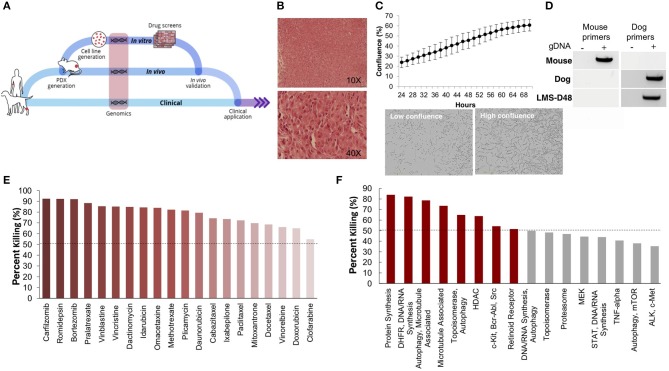
Patient-derived models of cancer enable seamless integration of high throughput drug screening with in vivo validations. (A) Schematic of the personalized medicine pipeline integrating in vitro and in vivo drug discovery and validation. (B) Hematoxylin and eosin stain of the patient derived xenograft model of the canine patient (LMS-D48) showing highly proliferative spindle-like cells. (C) The patient-derived cell line also displays a high proliferation rate, with an estimated doubling time of 26–36 h, and spindle-like mesenchymal morphology. (D) A species-specific PCR using mouse- and canine-specific primers confirms that the patient-derived cell line is of canine origin. (E) A preliminary drug screen of 119 FDA-approved compounds in the LMS-D48 cell line identified single standard-of-care agents and novel drug candidates. (F) Analysis of drug screen data at the pathway level showed sensitivity to protein synthesis, DNA/RNA synthesis, autophagy, and HDAC inhibitors. Novel agents, including HDAC inhibitors and proteasome inhibitors were identified as top candidates for validation.